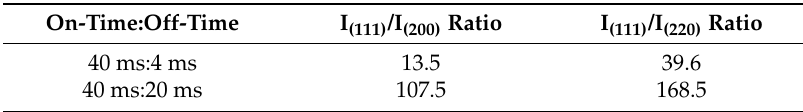
Figure 1. X-Ray diffraction patterns for the electroplated Au films of ( a ) on-off time 40 ms:4 ms; ( b ) on-off time 40 ms:20 ms. Table 1. The calculated intensity ratios of I (111) /I (200) and I (111) /I (220) of X-ray diffractions for 40 ms:4 ms and 40 ms:20 ms gold films.